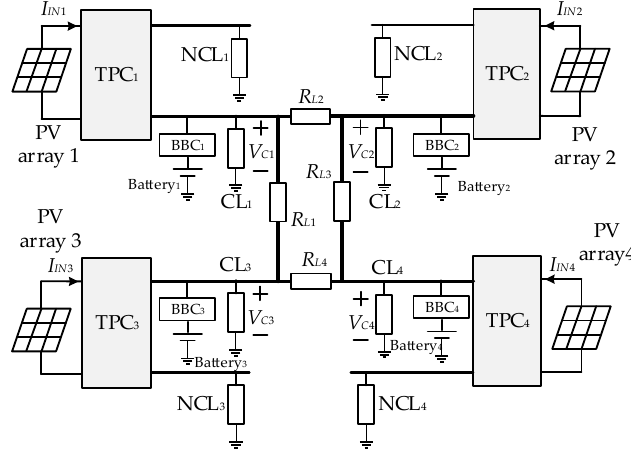
Figure 2. Structure of multiple DCESs.